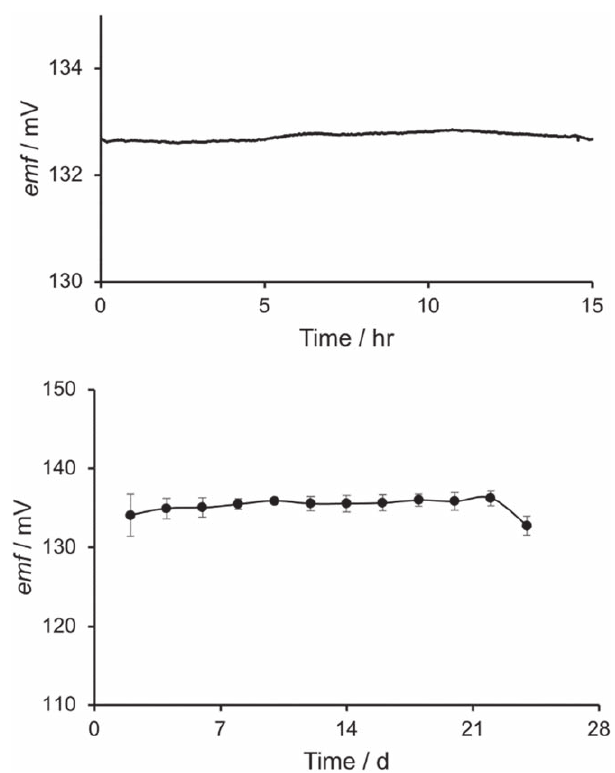
Figure 5. (A). An emf trace illustrating the stability of a Ca 2 + -ISE over a 15 h timeframe with an average drift of 166 μ V h − 1 and a total drift of 2.493 mV. (B). Experimental emf values of a Ca 2 + -ISE for determination of the shelf-life calcium doped LC-ISE over 24